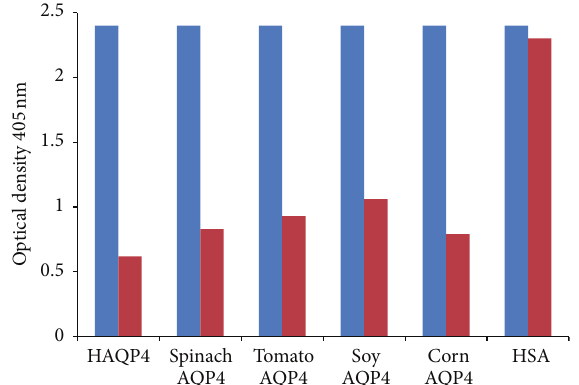
Figure 10: Inhibition of human AQP4 IgG antibody with human AQP4, spinach AQP4, tomato AQP4, soy AQP4, corn AQP4, and HSA. Controls = blue column; patients = red